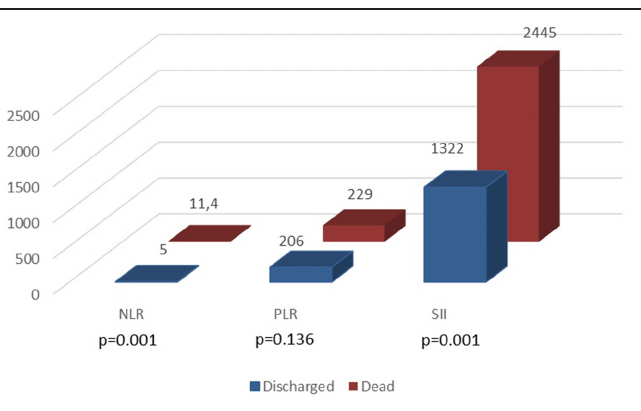
Figure 1. Comparison of NLR, PLR and SII between dead and discharged CKD patients with COVID-19. NLR, neutrophils to lymphocytes ratio; PLR, platelet to lymphocyte ratio; SII, systemic immune-inflammation index.